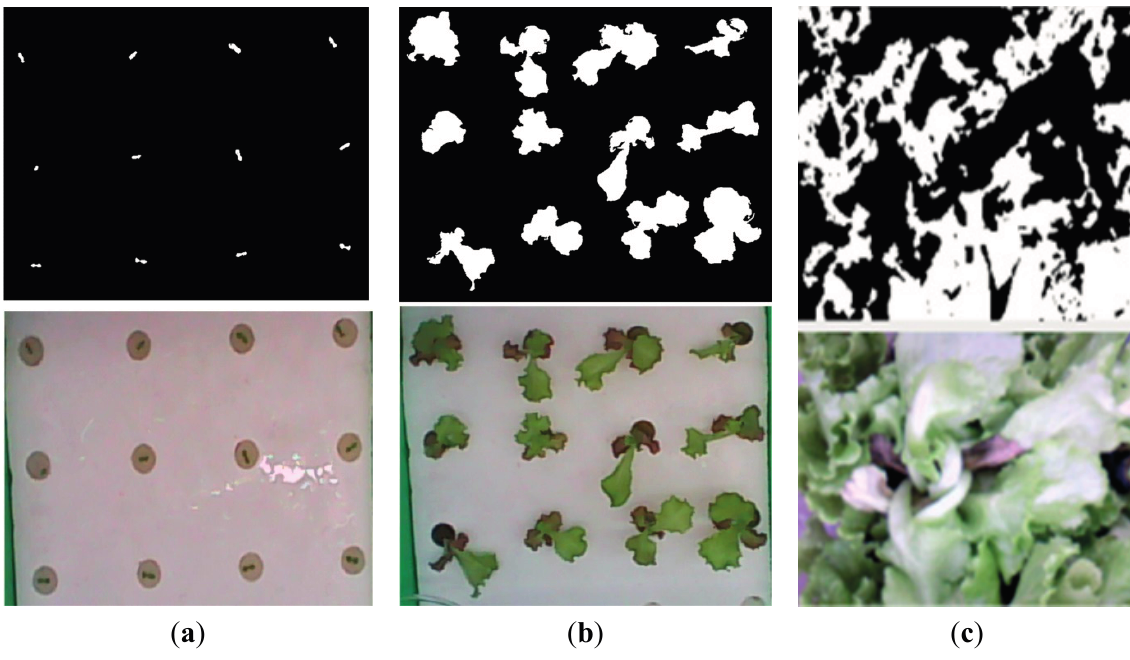
Figure 8. The results of the image process. ( a ) Seedling stage; ( b ) growth stage; ( c ) harvest